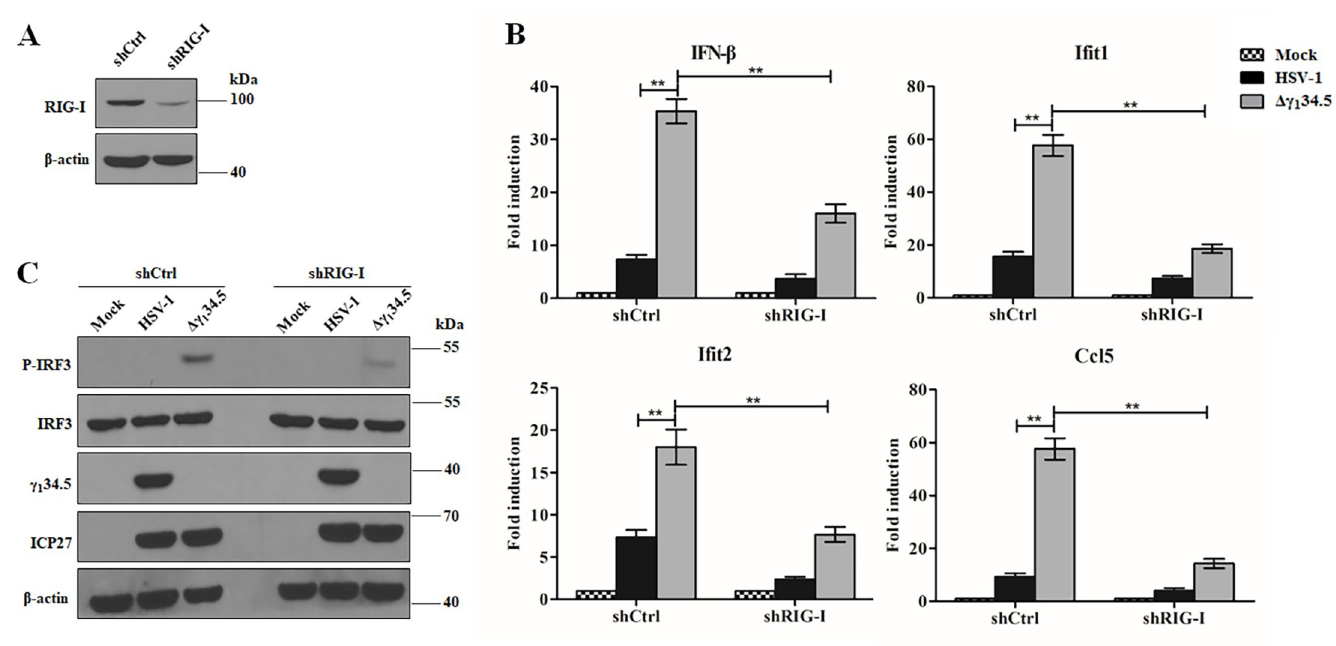
Fig 3. HSV-1 γ 1 34.5 reduces RIG-I dependent antiviral responses in human lung fibroblasts (HEL). (A) Validation of RIG-I knockdown in HEL cells. Cell lysates from HELs expressing control shRNA (shCtrl) or RIG-I target shRNA (shRIG-I) were subjected to western blot analysis with anti-RIG-I and β -actin antibodies. (B) Effects of γ 1 34.5 on antiviral gene expression in control or RIG-I knockdown HEL cells. Cells infected with wild type HSV-1 or Δγ 1 34.5 (5 pfu/cell) for 8 h were analyzed for transcript levels of IFN- β , Ifit1, Ifit2, and Ccl5 by quantitative PCR analysis. The data were statistically analyzed by one-way ANOVA ( �� , P < 0.01) with SD (n = 3). (C) Effects of γ 1 34.5 on IRF3 phosphorylation in shCtrl-transfected HEL or RIG-I knockdown HEL. Cells were infected as described in panel B and processed for Western blot analysis with antibodies against p-IRF3, IRF3, ICP27, γ 1 34.5 and β -actin. The experimental data are representative of results from three independent experiments.